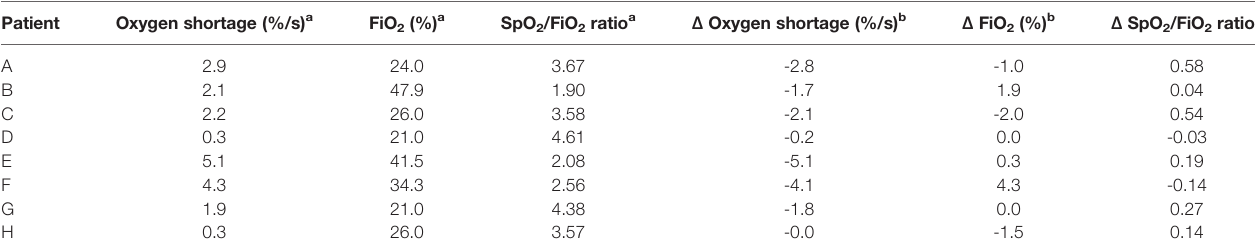
TABLE 3 | The individual values at 1 h before doxapram, and the changes from 1 h before until 4 h after doxapram